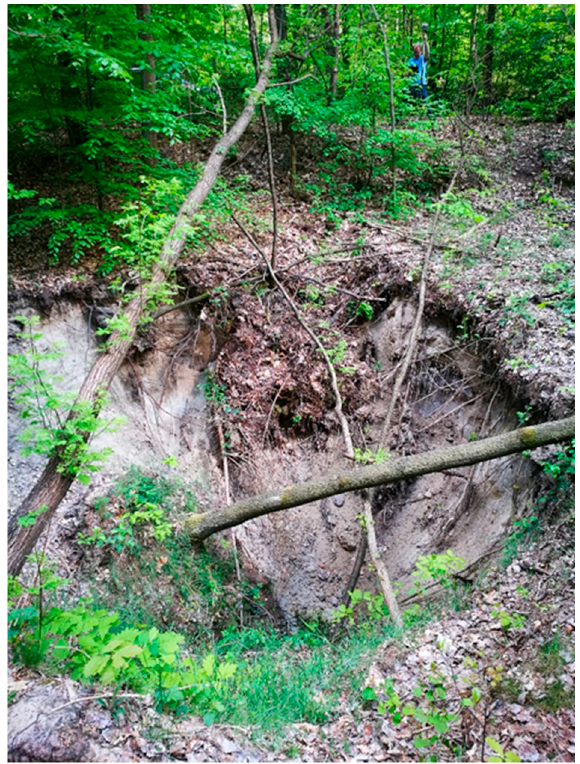
Figure 11. Photo of the recent sinkhole in the study area.